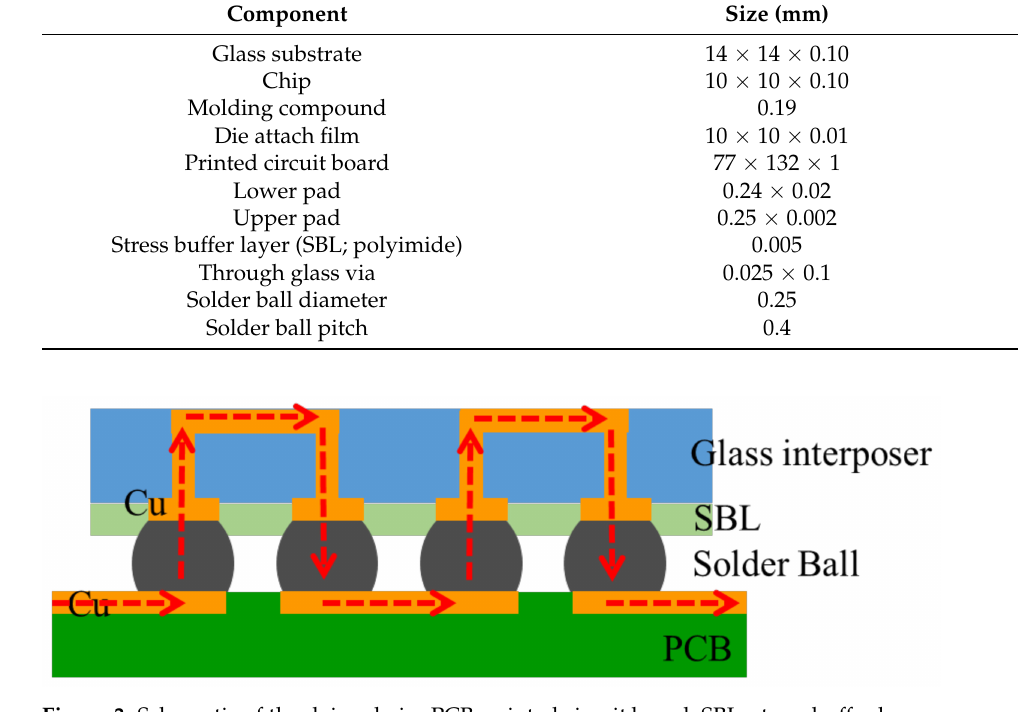
Figure 3. Schematic of the daisy chain. PCB, printed circuit board; SBL, stress buffer